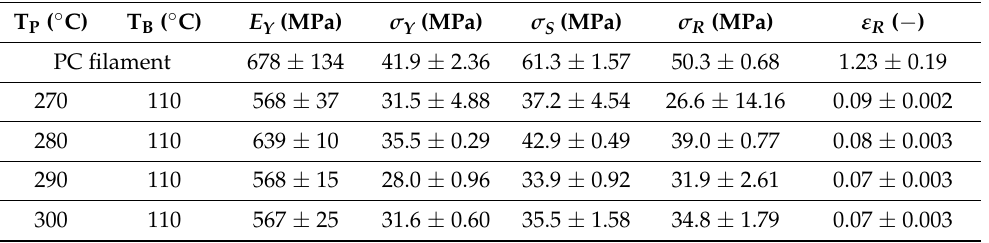
Figure 6. Stretching stages of PC filament up to rupture point.